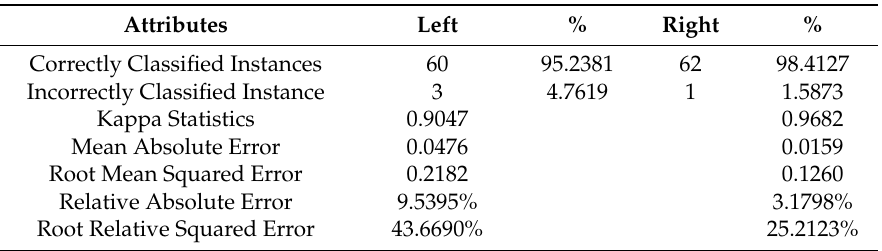
Table 2. Support Vector Machine ( SVM) Numerical Assessments.